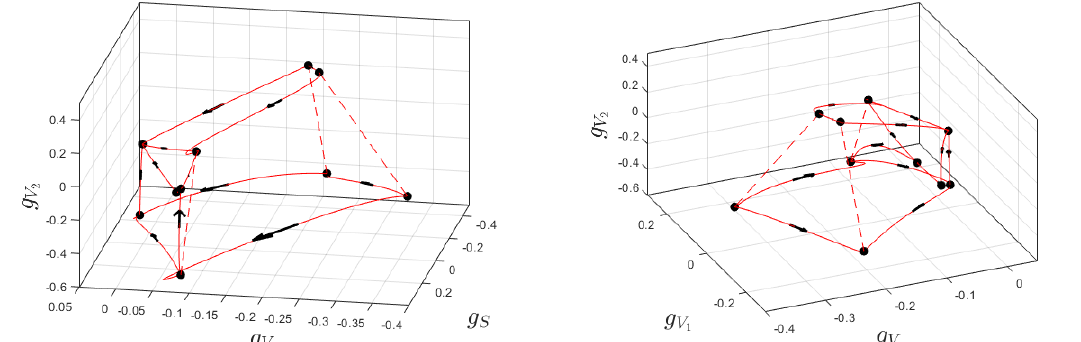
4 model (2.7) at ( N c ; N f ) = )- 2 ; g V )-space. 1 2